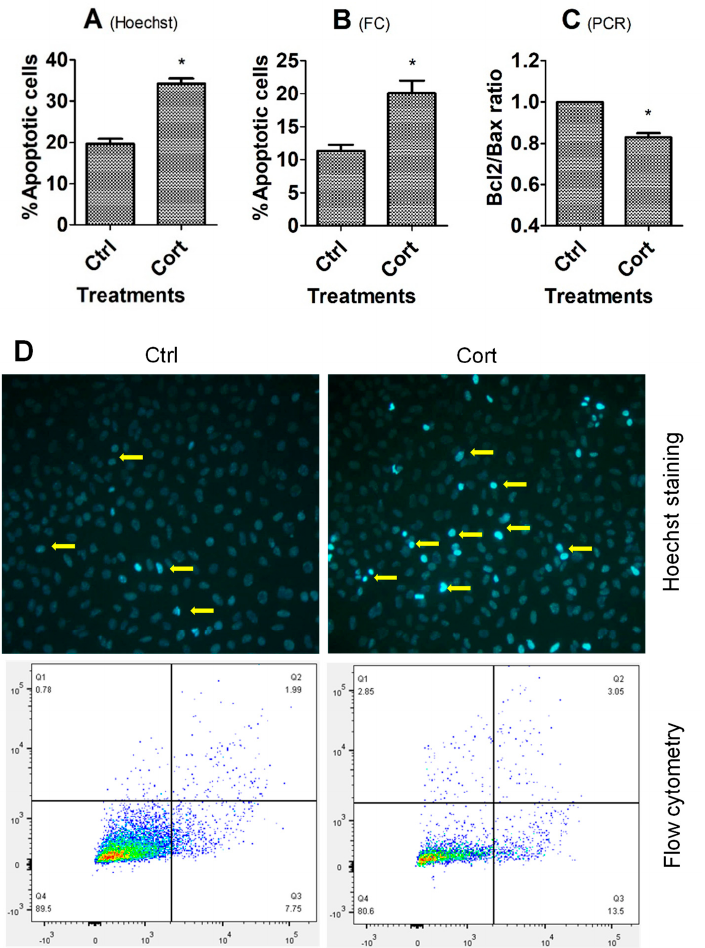
Figure 1. Effects of corticosterone treatment on apoptosis of MGCs. Graphs ( A – C ) show percentages of apoptotic cells revealed by Hoechst staining or flow cytometry (FC), and the ratio of Bcl2/Bax measured by RT-PCR, respectively, between untreated control (Ctrl) and corticosterone (Cort) treated cells. Each treatment was repeated 3 times with each replicate including cells from 2 wells of a 6-well plate from 12 mice. * Indicates significant difference ( p < 0.05) from controls. In graph ( B ), the percentages of apoptotic cells included both early and late apoptotic cells. In graph ( C ), the ratio of Bcl2/Bax mRNA in Ctrl cells was set to one and the ratio in Cort-treated cells was expressed relative to it. Panel ( D ) shows images and the flow cytometry graphs of MGCs in the Ctrl or Cort groups. The MGC images were obtained under a fluorescence microscope after Hoechst staining. Original magnification was 400×. Arrows indicate representative apoptotic cells with pyknotic nuclei heavily stained by Hoechst 33342. The flow cytometry graphs were obtained following annexin-V and PI staining. The healthy, early and late apoptotic cells are located in the Q4, Q3 and Q2 area, respectively. The Q1 area contains necrotic cells and mechanically damaged cell debris.